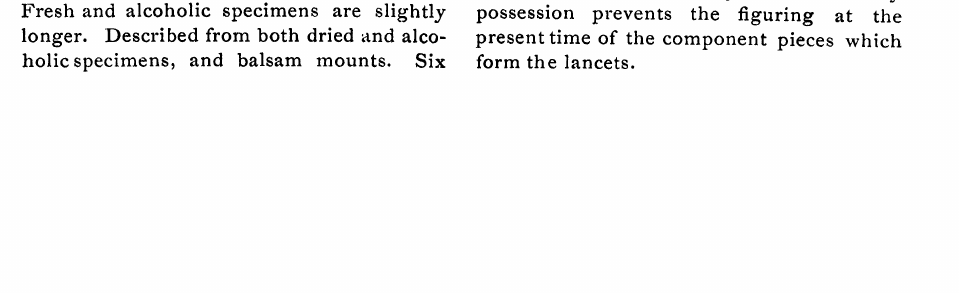
Fig. 4.--Hind leg, with coxa attached. Fig. 5.--Middle leg. Fig. 6.--Front leg. Figs. 2 to 5 are enlarged on the same scale. Fig. is still more greatly enlarged. The hair lines accornpanying